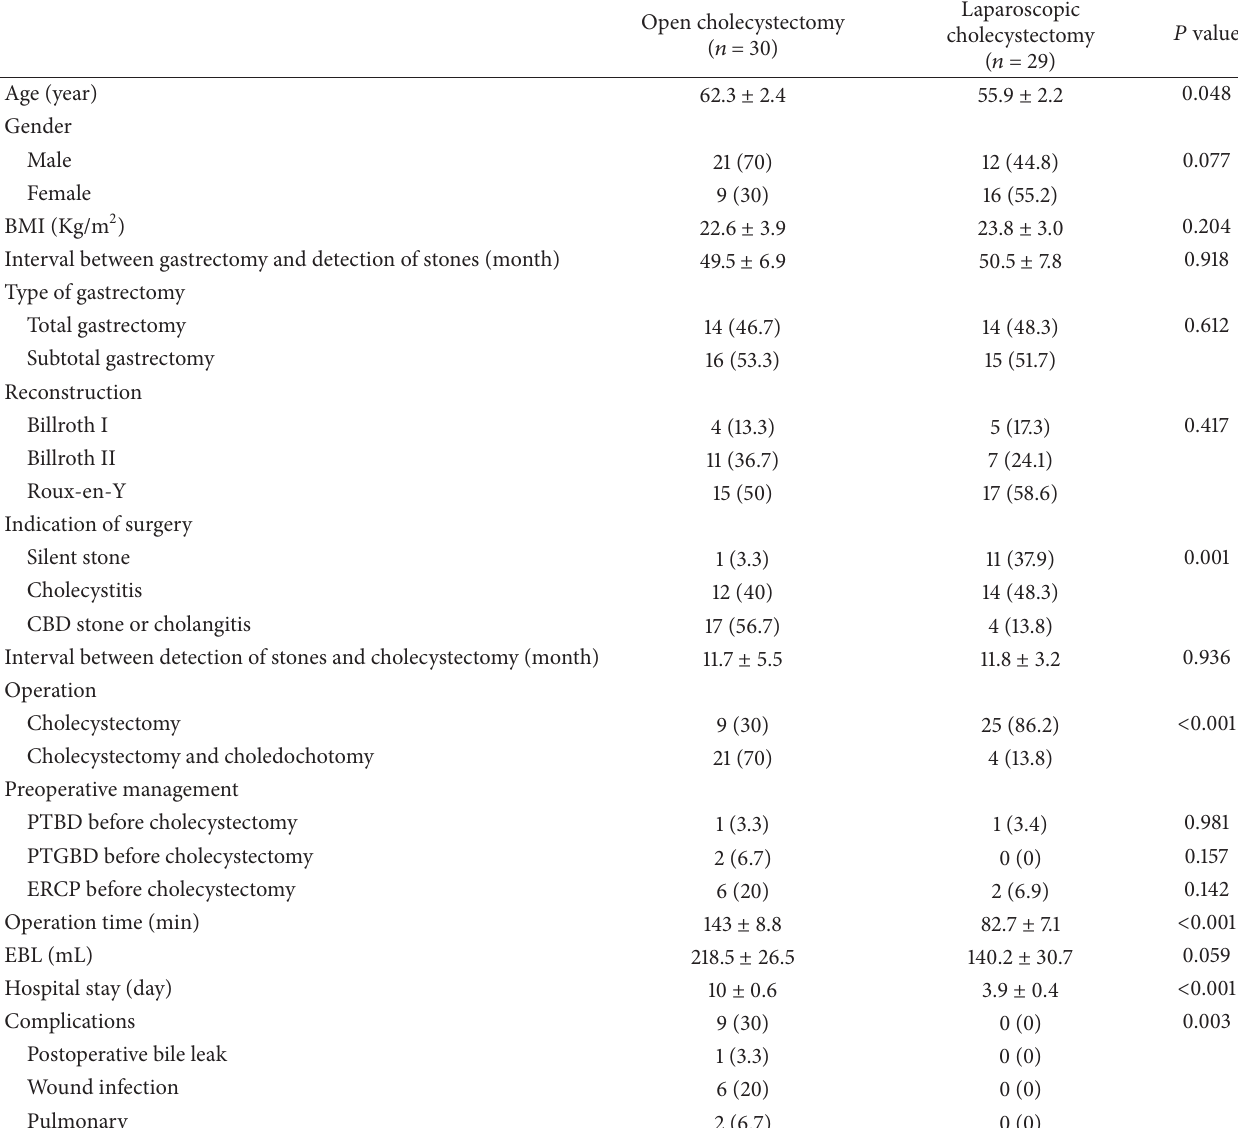
Table 3: Surgical treatment for gallstone disease after